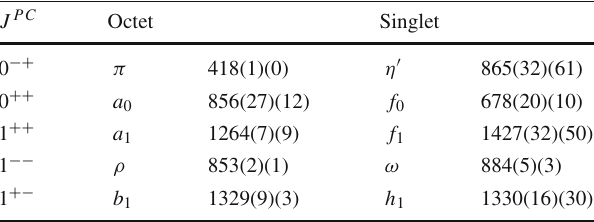
Table 3 Estimated meson masses in MeV from ensemble H101. The first uncertainty is statistical and the second was determined by varying